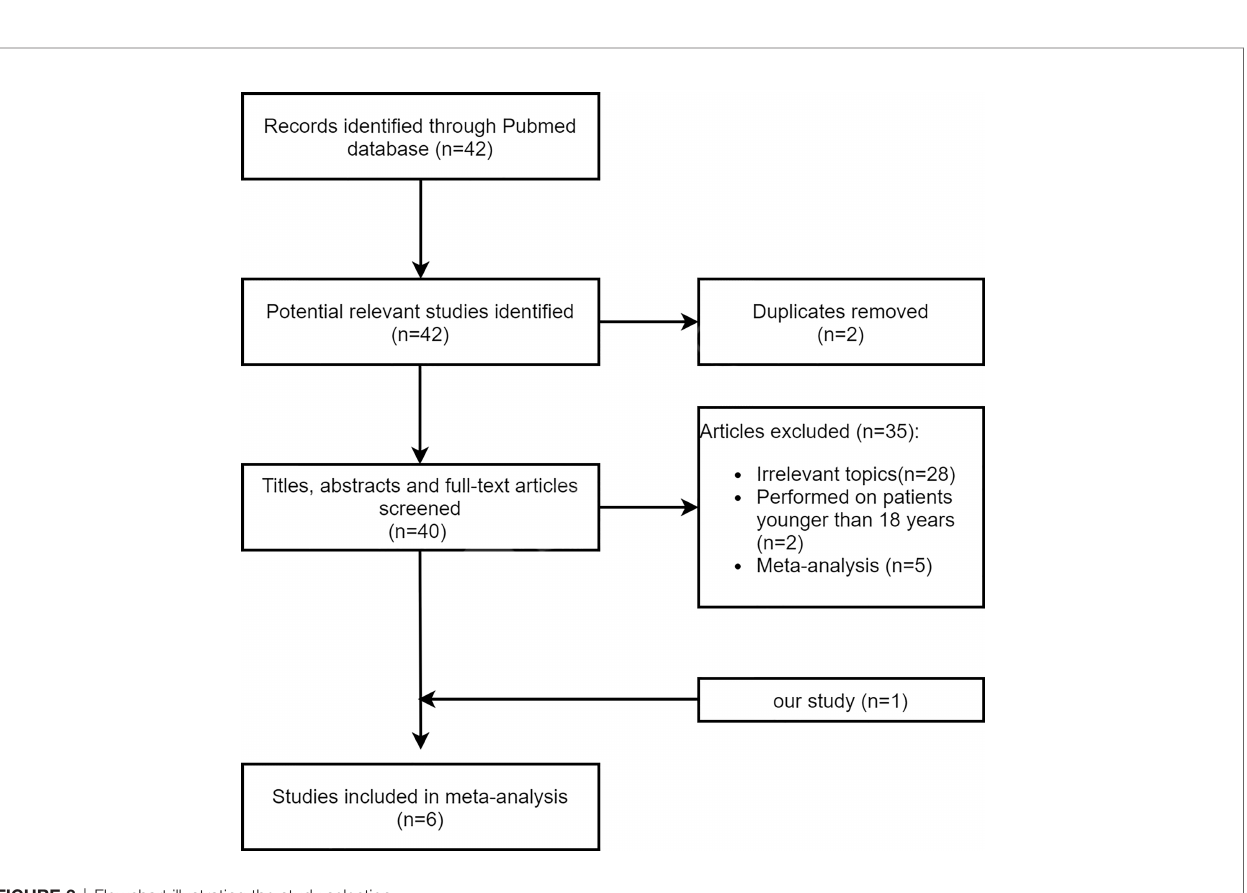
FIGURE 3 | Flowchart illustrating the study